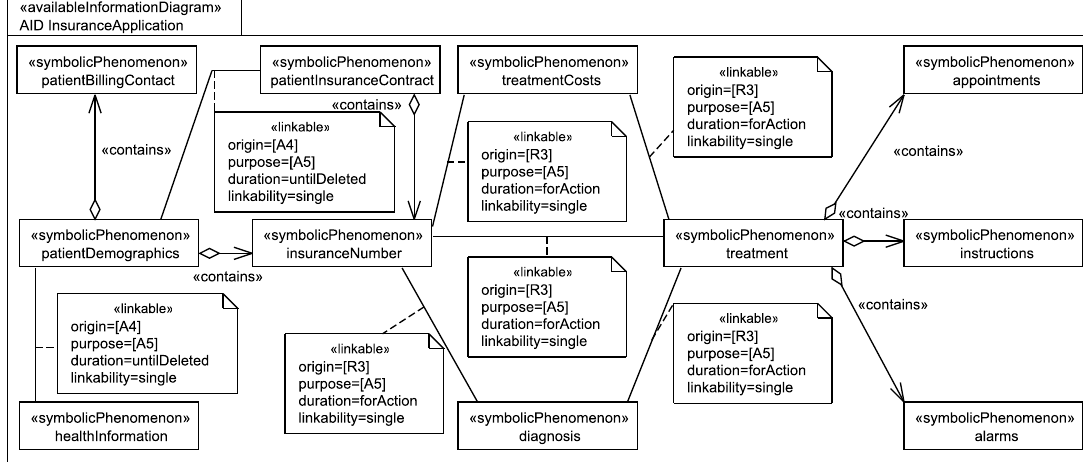
Figure 9. View on the available information diagram for the insurance application showing which links between the personal data of the patient are available at the insurance